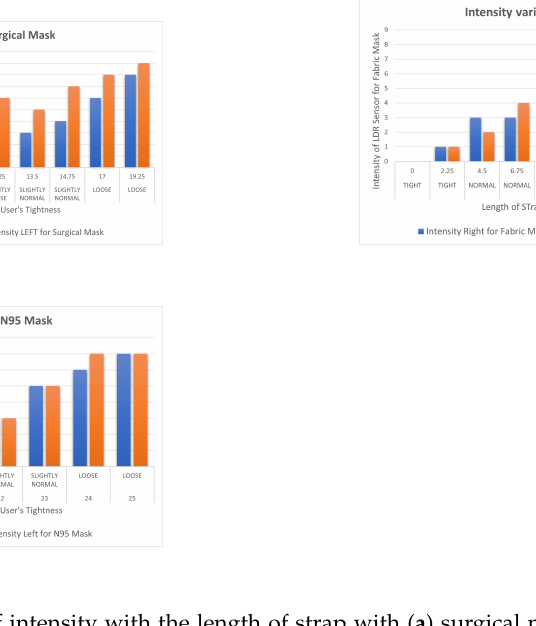
Figure 11. Variation of intensity with the length of strap with ( a ) surgical mask, ( b ) fabric mask, ( c ) KN95